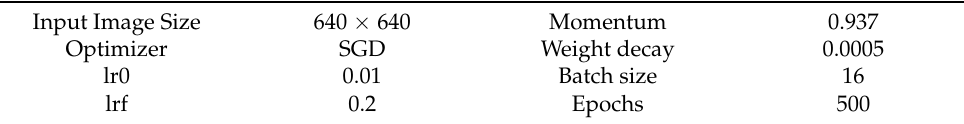
Table 1. Network training parameters